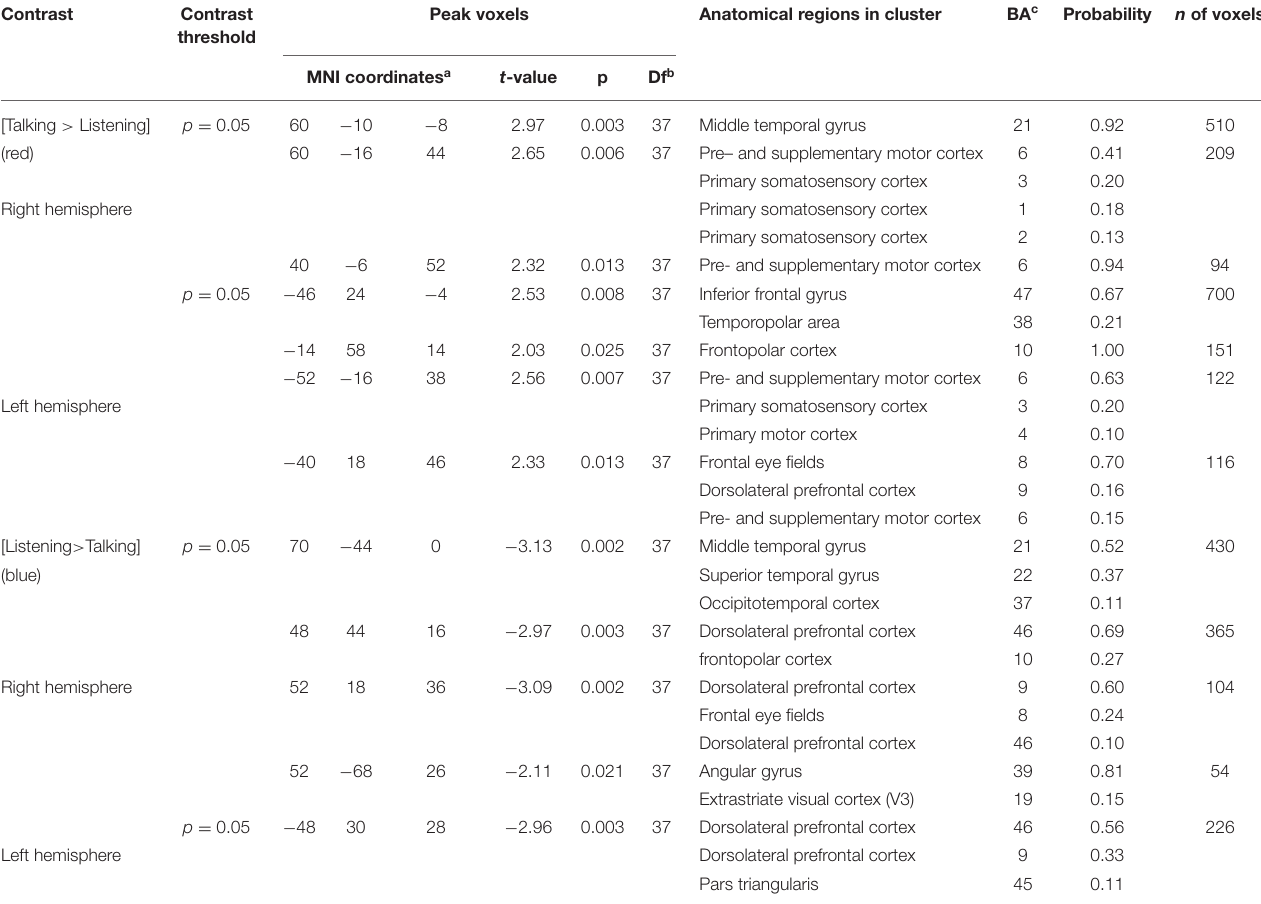
TABLE 4 | GLM contrast comparison: agree [Talking > Listening] with ASE co-regressor, (deOxyHb signals). Contrast Contrast Peak voxels Anatomical regions in cluster BA c Probability n of threshold